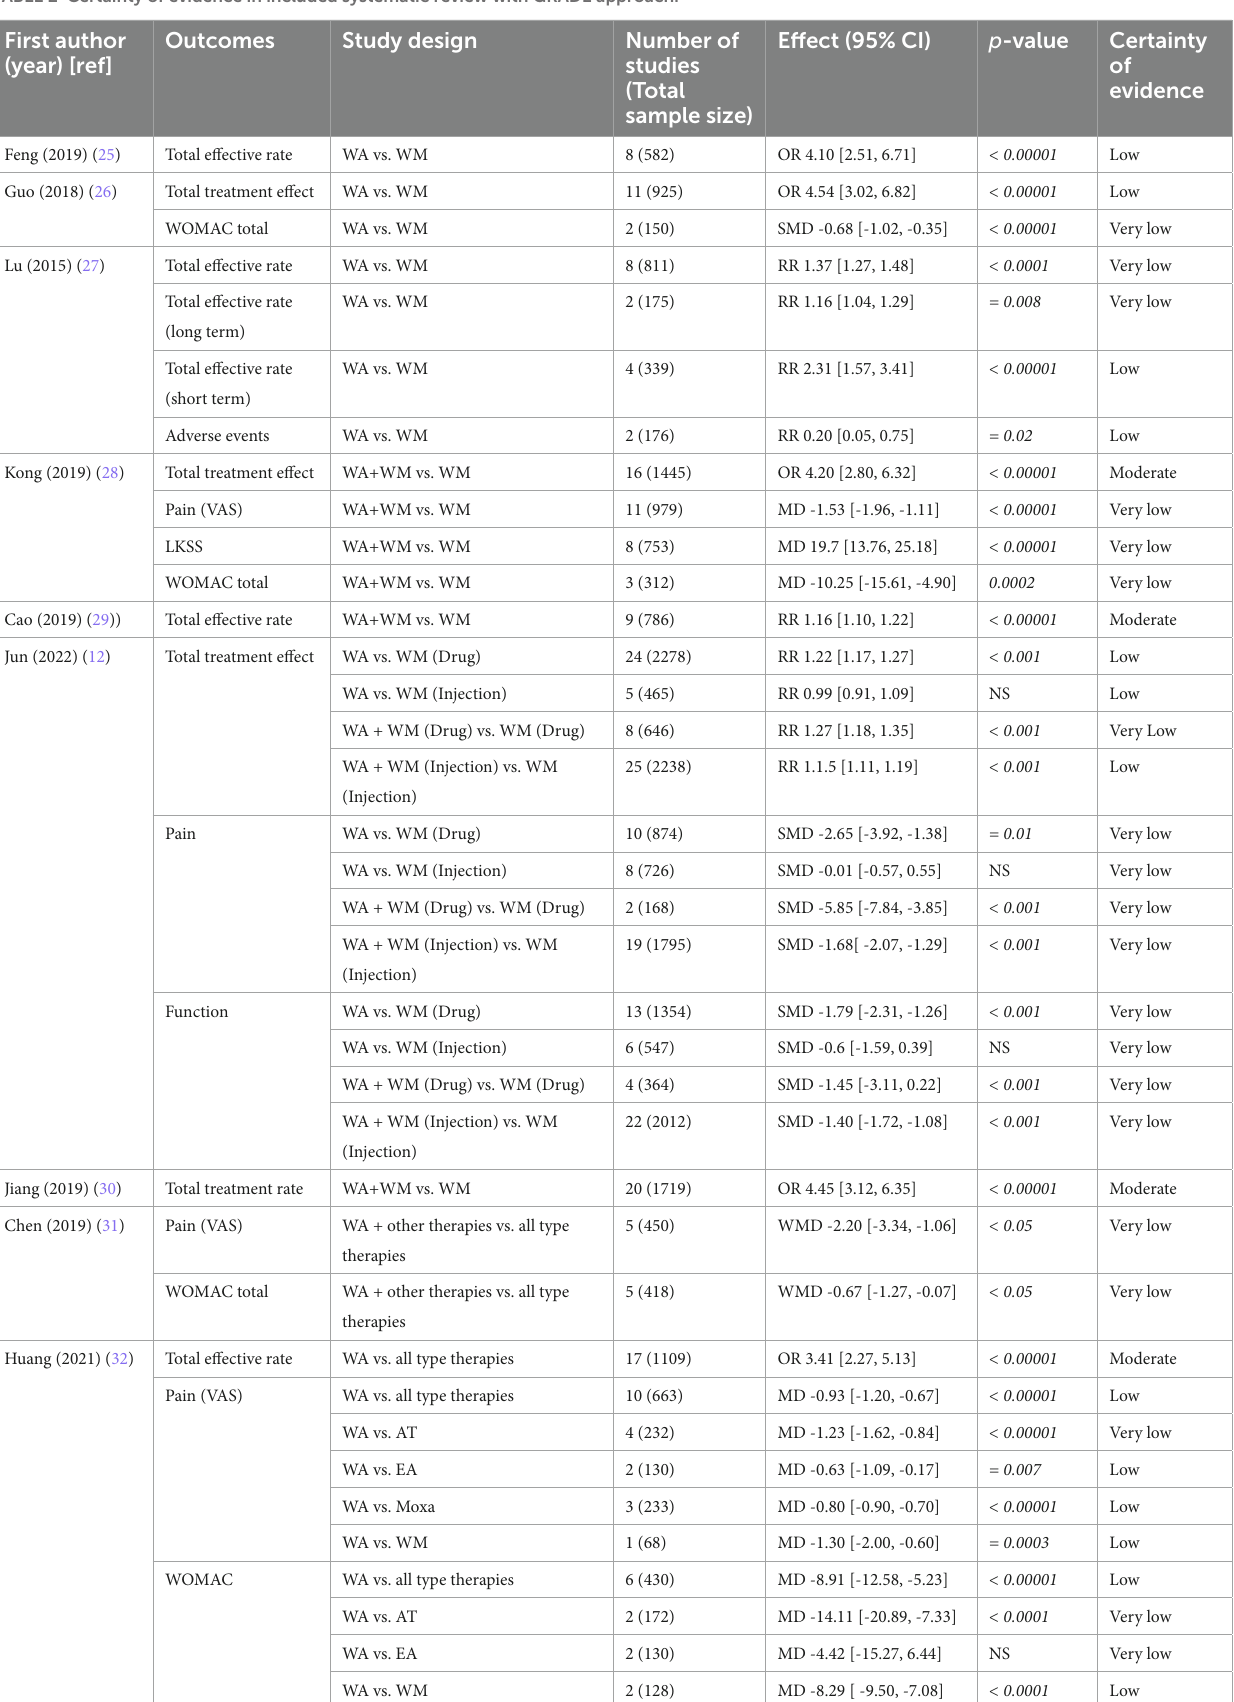
TABLE 2 Certainty of evidence in included systematic review with GRADE